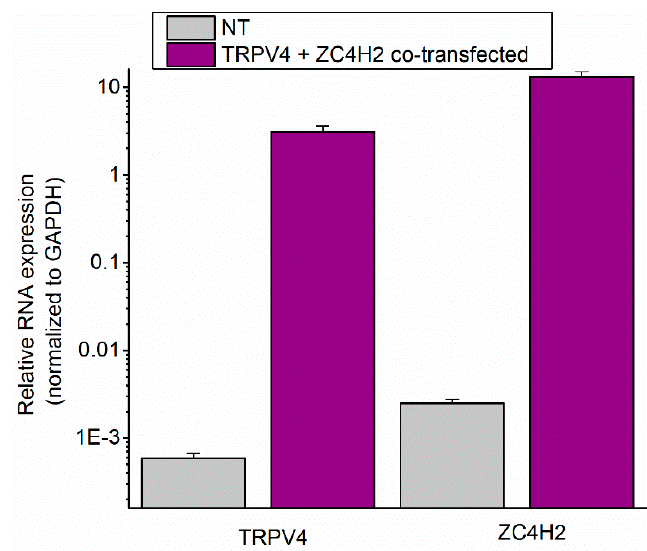
Figure A1. Initial evaluation of other MAPPIT hits. mRNA expression of TRPV4 and the indicated MAPPIT hits in the indicated mouse tissues. Values were normalized to the internal control HPRT. PNMA1 expression was low in all samples, while abLIM3 was primarily found in tissues with low TRPV4 expression.